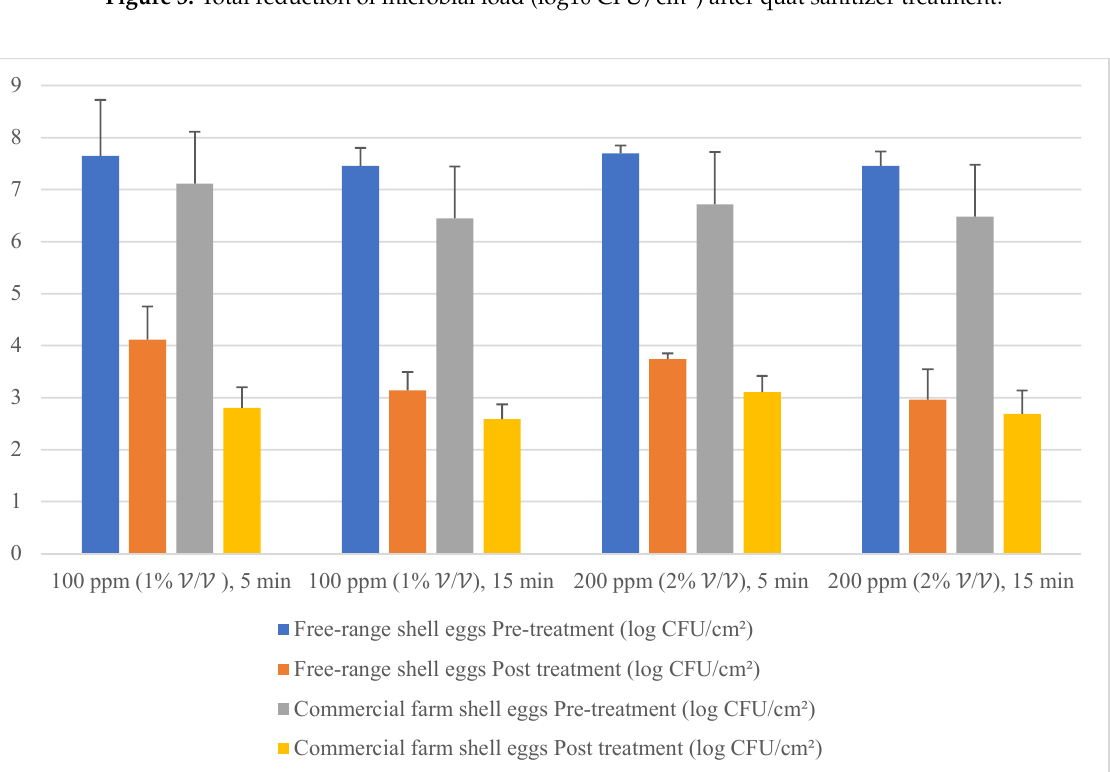
Figure 5. Mean population of yeasts (pre- and post-treatment) for free-range shell eggs and commercial farm shell eggs.